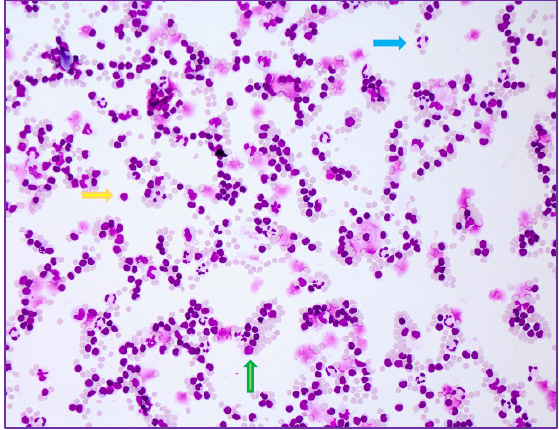
Figure 2. Mixed cell reaction with lymphocytes (yellow arrow), monocytes (green arrow) and neutrophils (blue arrow) in the CSF sample of the 14-year-old patient (20× magnification).